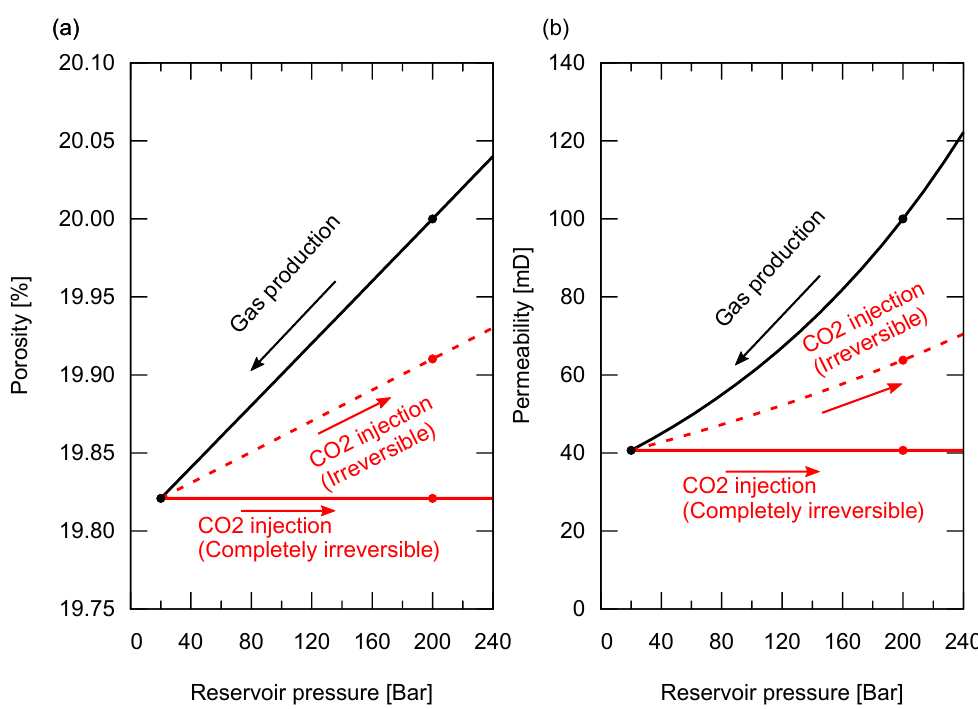
Figure 9. Porosity and permeability compaction as a function of reservoir pressure. ( a ) Porosity compaction trend with C p = 5 × 10 − 5 bar − 1 in the black line, irreversible expansion trend with C p = 2.5 × 10 − 5 bar − 1 in the red dotted line, and completely irreversible in the red line; ( b ) Permeability compaction trend with γ = 5 × 10 − 3 bar − 1 in the black line, irreversible expansion trend with γ = 2.5 × 10 − 3 bar − 1 in the red dotted line, and completely irreversible in the red line.